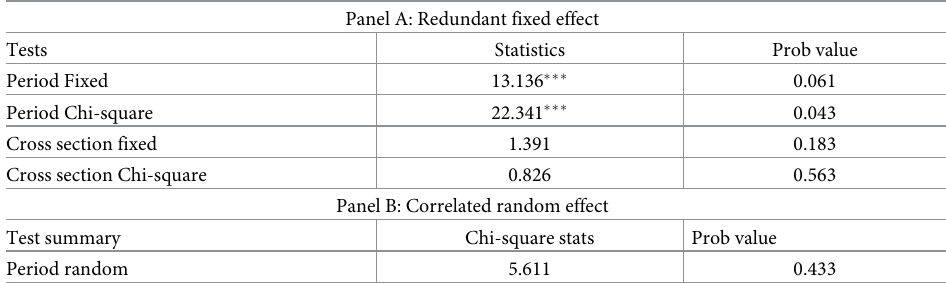
Table 3. Fixed and random effect test.